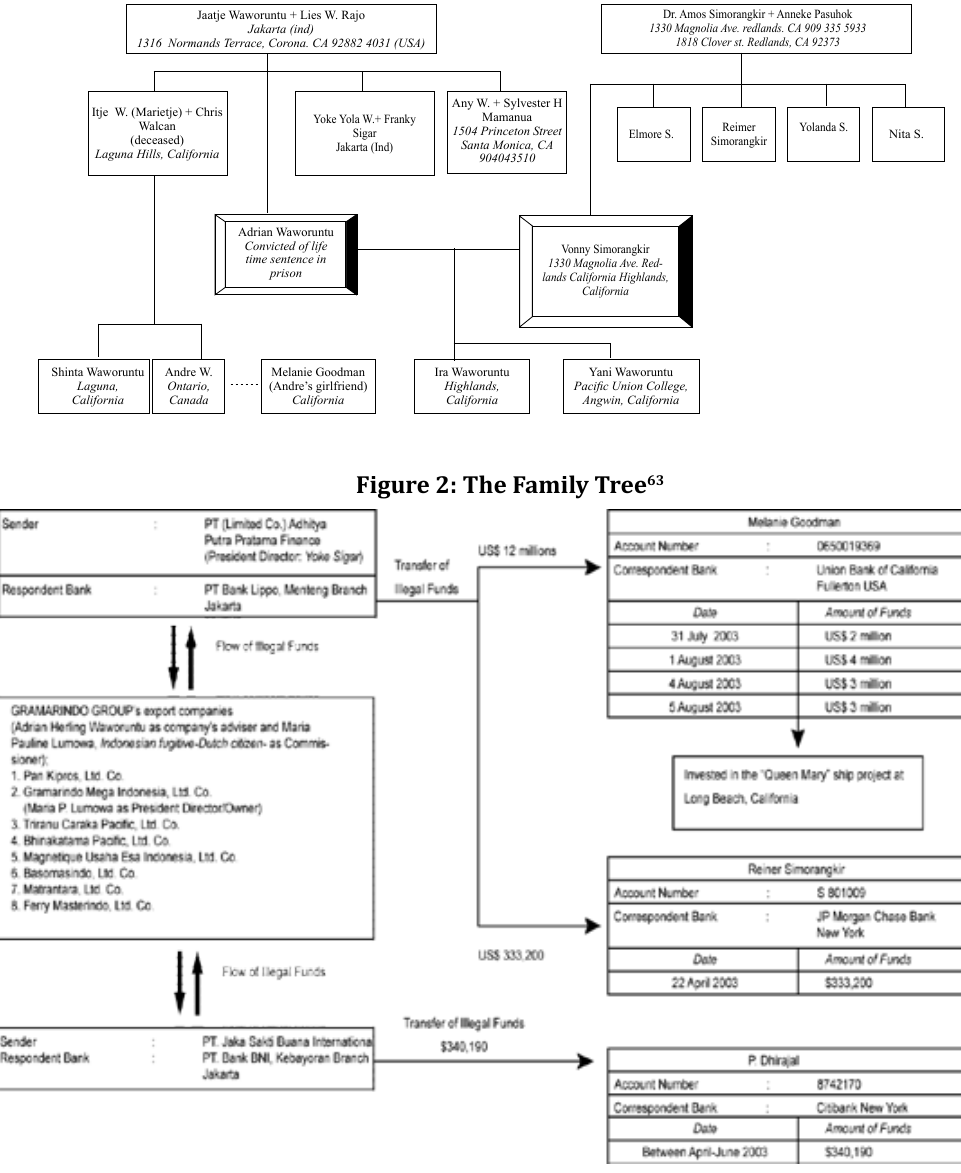
Figure 3: The Flow of the Money